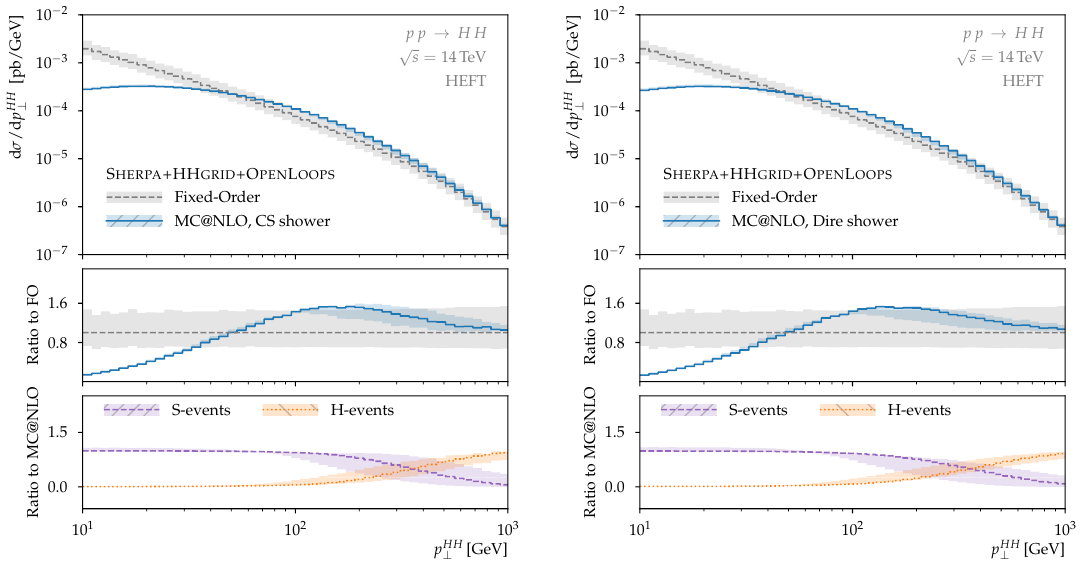
Figure 4 . Parton shower NLO matching e(cid:11)ects on the p HH